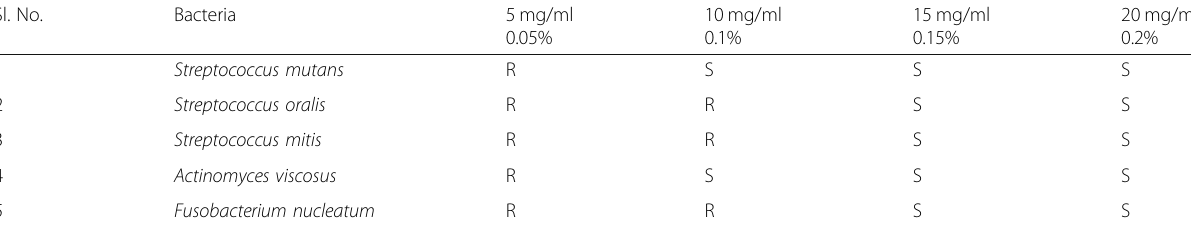
Table 1 Concentrations of Guava L extract tested for bacterial strains commonly present in supragingival plaque Sl.